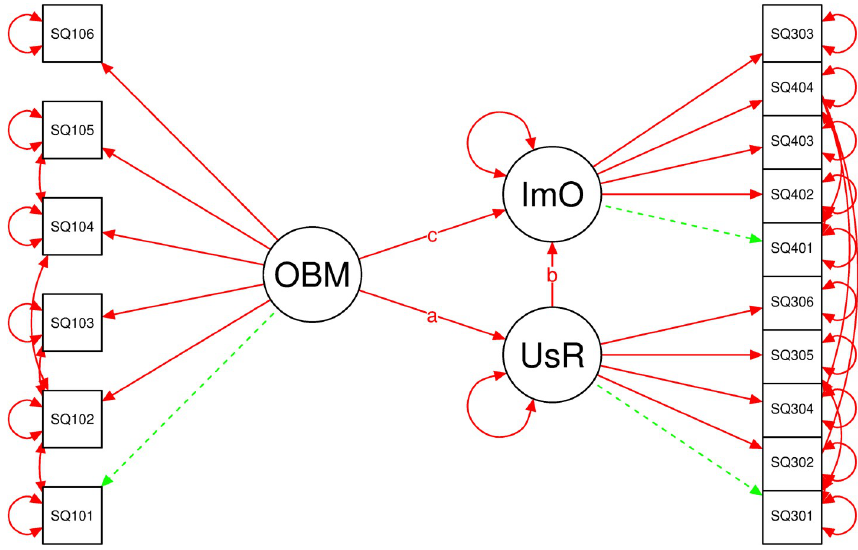
Fig 6. Structural model showing the relationship between omics-based biomarkers (OBM), public genomic awareness represented by user response (UsR) and precision medicine implementation outcomes (ImO). Red lines indicate estimated parameters while green lines indicate fixed